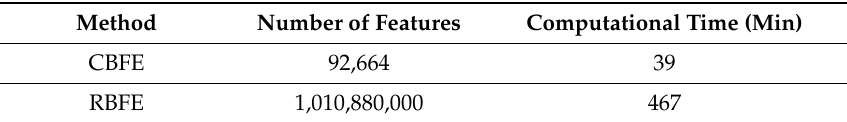
Table 4. Comparison of the performances of CBFE and RBFE